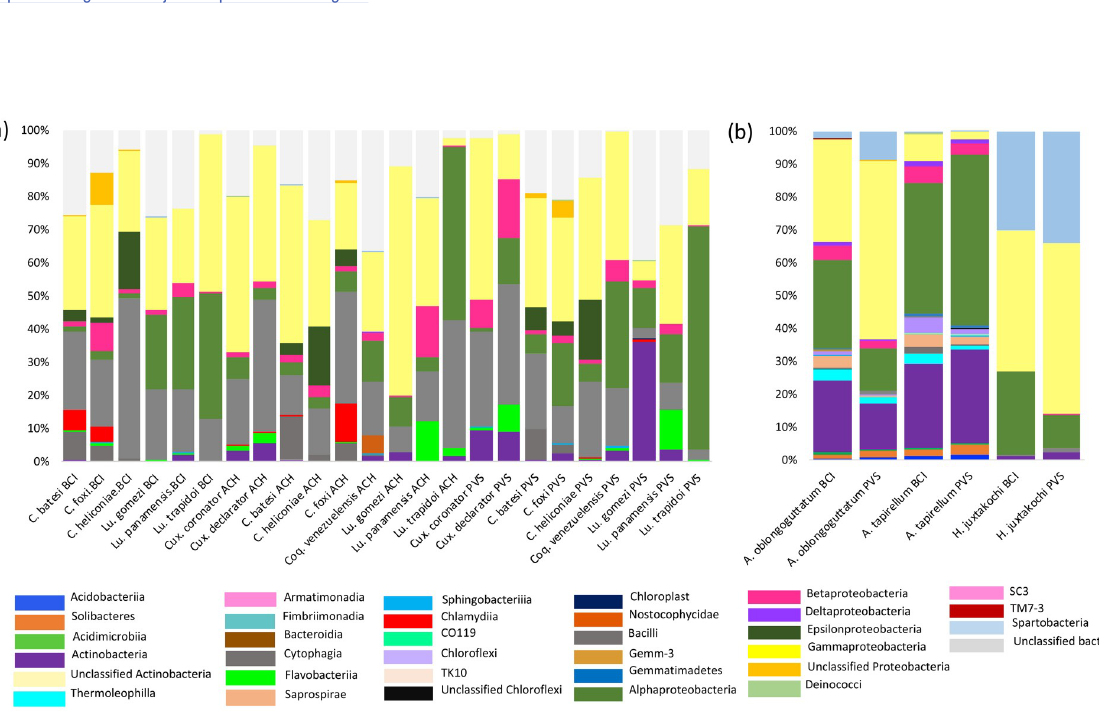
PLOS ONE | https://doi.org/10.1371/journal.pone.0225226 November7, 2019 2 /